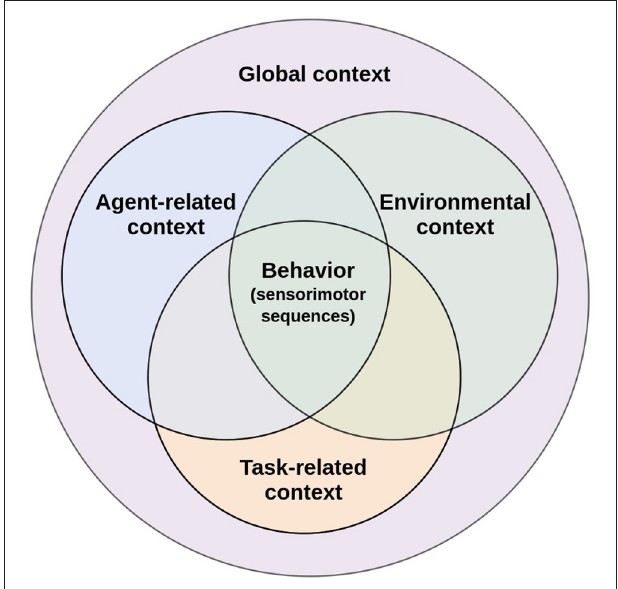
FIGURE 1 | Agent-related context, environmental context, and task-related context are intertwined together to influence behavior. Figure adapted from Cohen